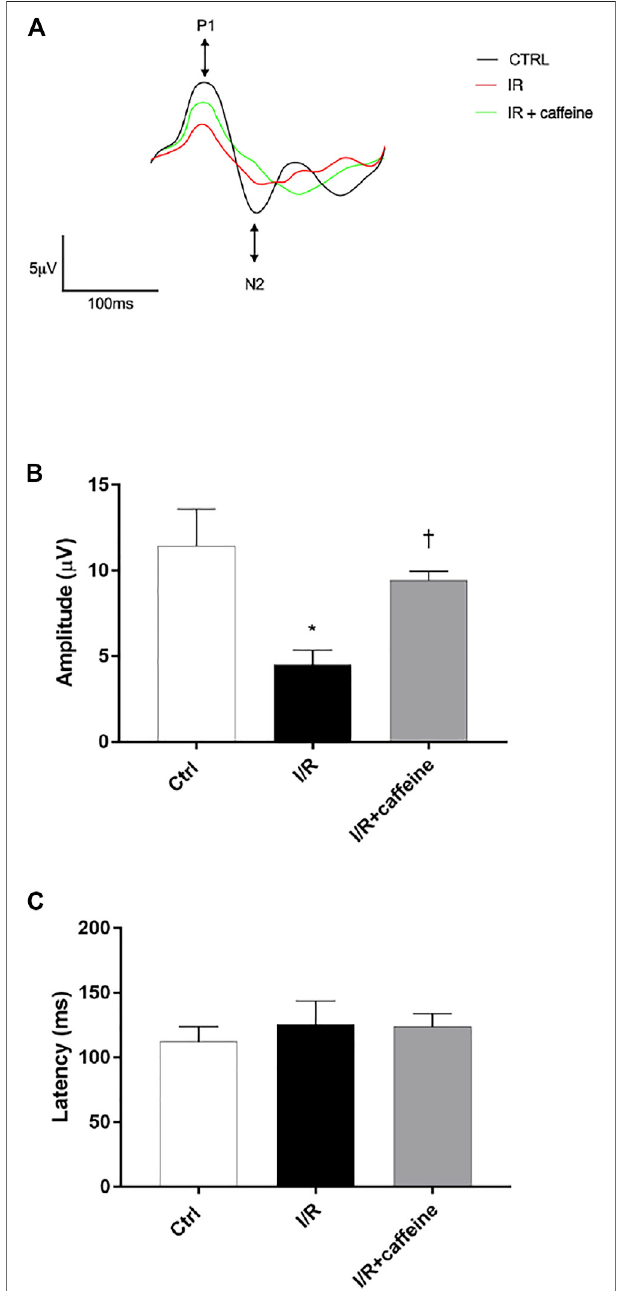
FIGURE 7 | Caffeine counteracts RGC loss of function induced by I/R injury in mouse retinas. RGC function was assessed by the pattern electroretinogram (PERG). (A) Representative waveforms of PERG of all experimental groups (C57BL/6J mouse control (Ctrl), I/R, and I/R + caffeine). Each waveform, deriving from PERG recordings, was analyzed for the peak-to-trough amplitude (P1-N2). (B) Comparison between PERG amplitude values (µV) and latency values (ms). (C) of control, I/R, and I/R + caffeine. In each panel, bars represent the mean values ± S.D; n (cid:1) 4. One- way ANOVA analysis was performed followed by the Tukey post hoc test. * p < 0.05 vs . Ctrl; † p < 0.05 vs . I/R.